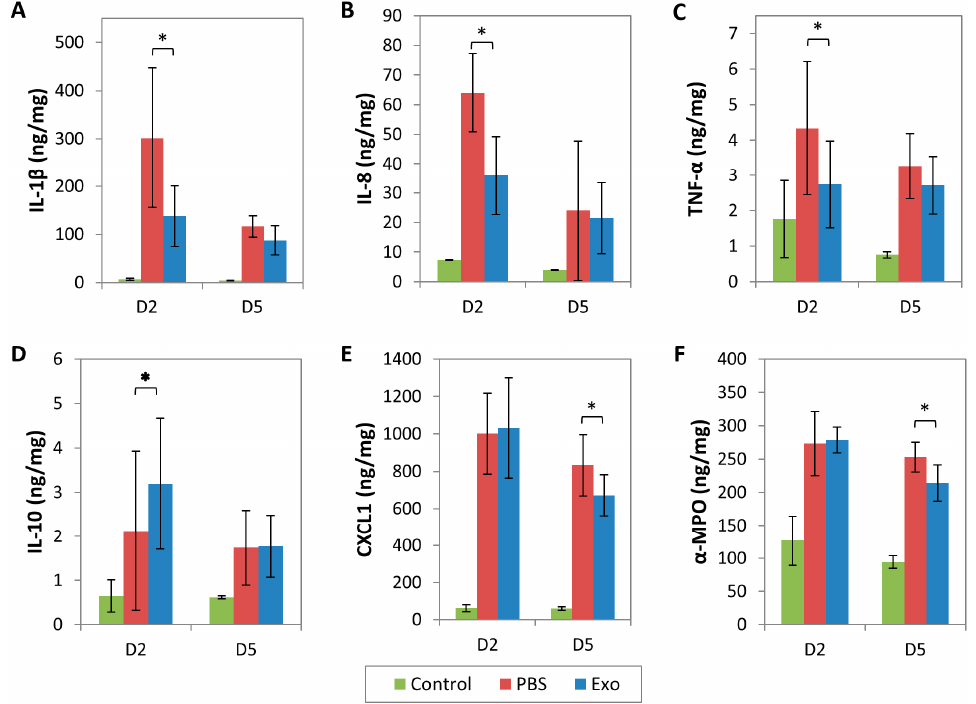
Figure 6. Host immune responses to laser-induced corneal scarring in rats on days 2 and 5 after topical application of mesenchymal stem cells-derived exosomes (MSC-exo) or phosphate-buffered saline (PBS). Pro-inflammatory cytokines IL-1 β ( A ), IL-8 ( B ), and TNF- α ( C ) and anti-inflammatory IL-10 ( D ) expression were detected using multiplex immunoassay, whereas chemokine CXCL1 ( E ) and activated neutrophil marker α -myeloperoxidase ( α -MPO) ( F ) expression were measured using ELISA. D2 = day 2; D5 = day 5. * p < 0.05.